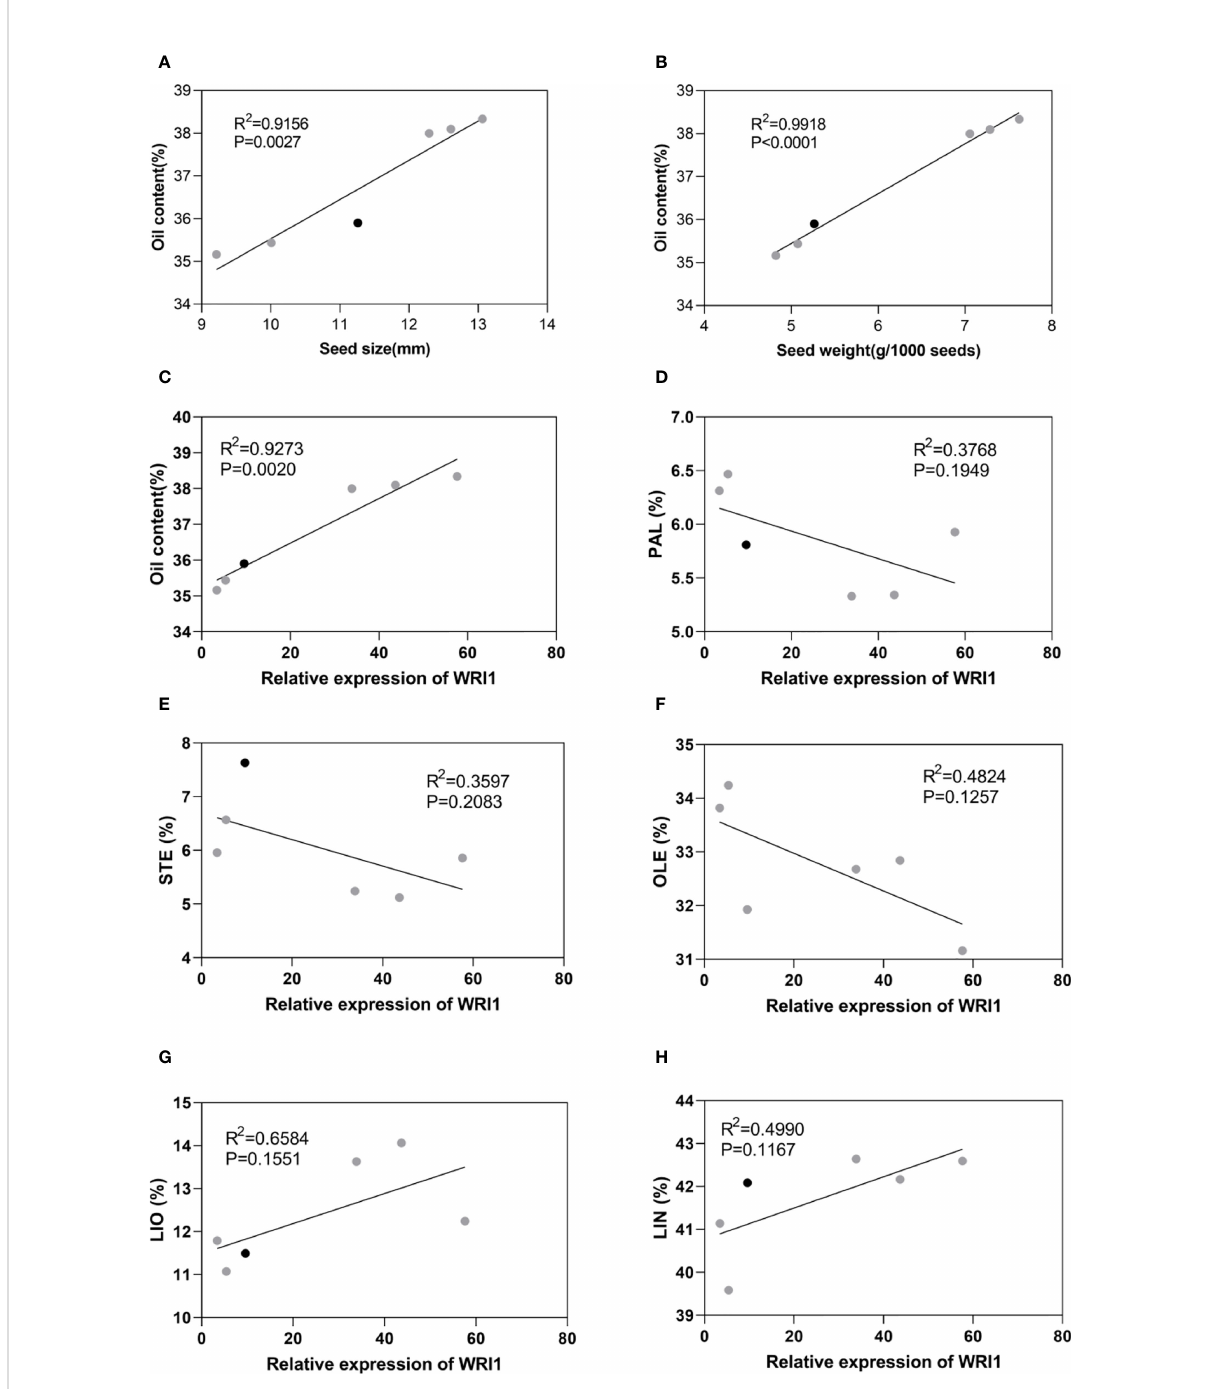
FIGURE 6 Correlation analysis in WT (black) and transgenic lines of fl ax (gray). (A) Correlation analysis between seed oil content and seed size. (B) Correlation analysis between seed oil content and seed weight. (C) Correlation analysis between seed oil content and expression levels of WRI1. (D – H) Correlation analysis between relative expression of WRI1 and PAL(%), STE(%), OLE(%), LIO(%), and